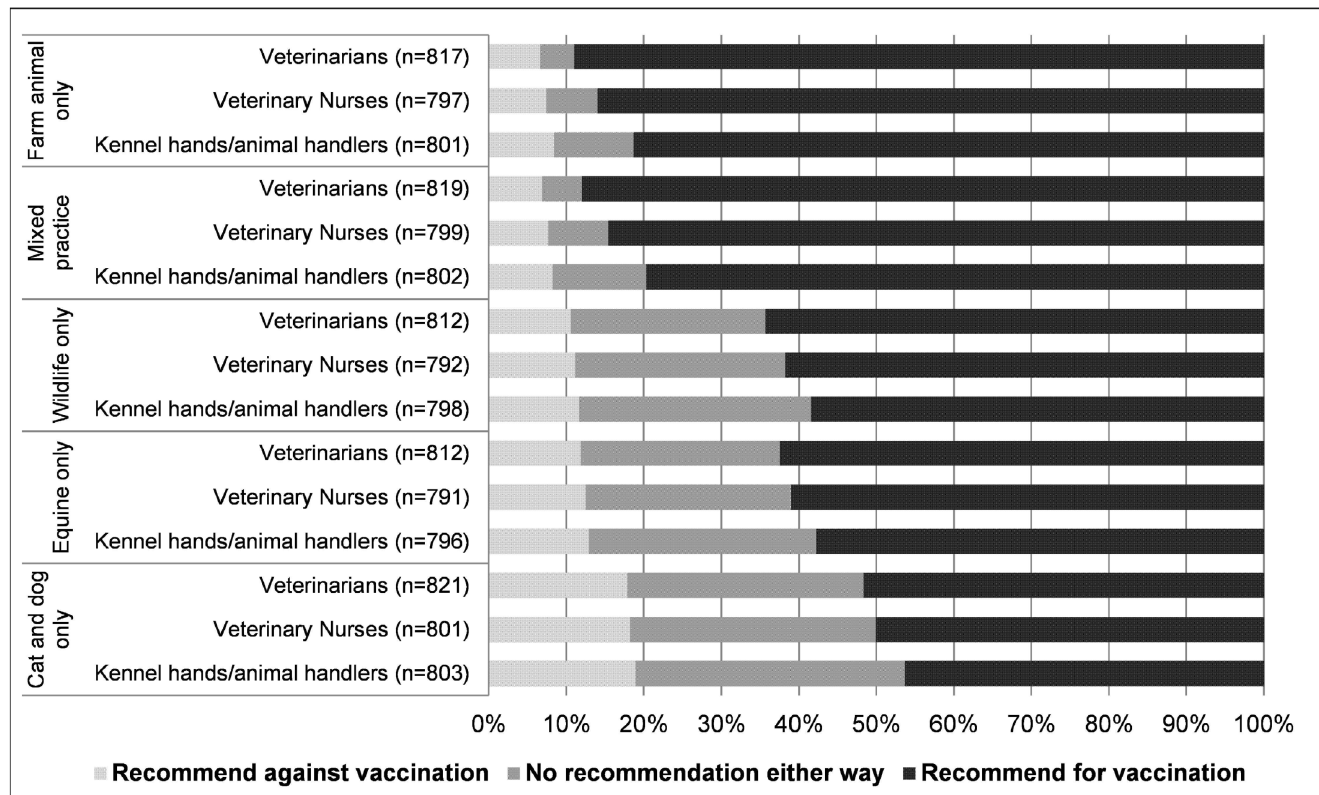
Fig 1. Responses from veterinarians (n = 828) surveyed in Australia in 2014 reflecting their recommendation for Q fever vaccination in veterinary personnel. The percentage of veterinarians recommending for vaccination, against vaccination, and with no recommendation either way for veterinary occupational groups (veterinarians, veterinary nurses, kennel hands/ animal handlers) is presented for each practice type queried. Not all respondents provided a recommendation for all occupations across all practice types.